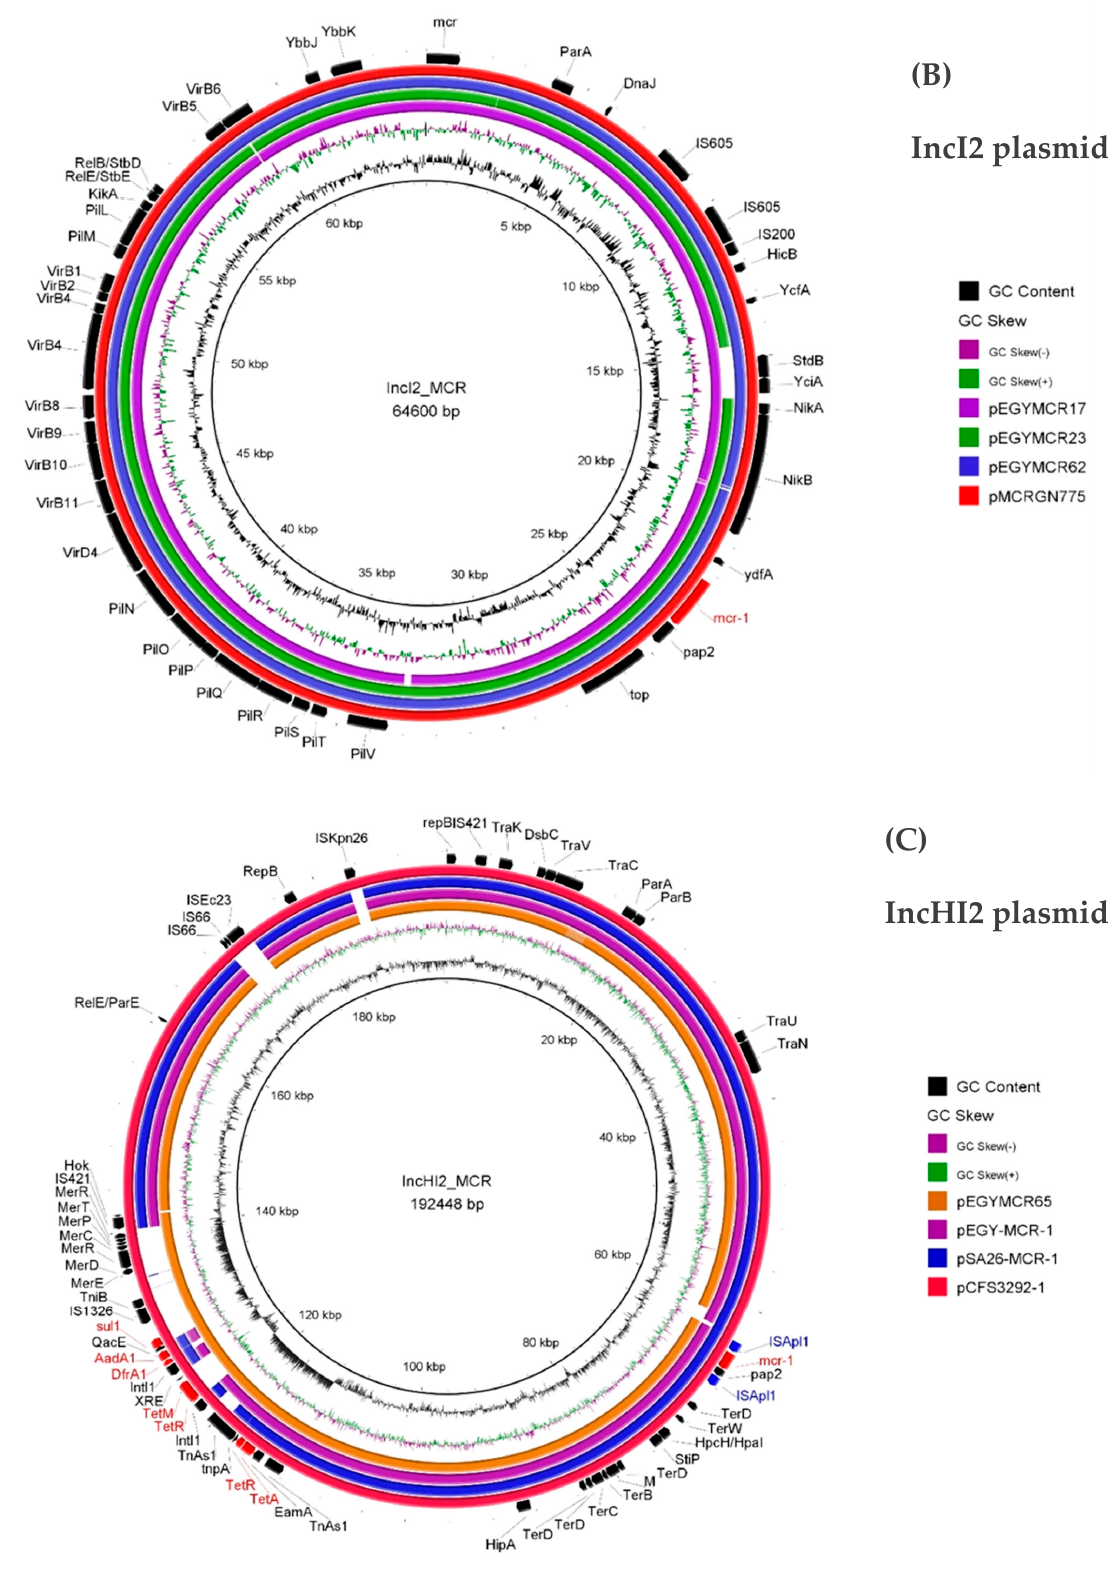
Figure 1. Circular map of mcr-1 -positive plasmids compared to other reported similar plasmids. Panel ( A ) IncX4 plasmids, panel ( B ) IncI2, panel ( C ) IncHI2. Red outer ring: plasmid used as reference for the alignment; size of the reference indicated in the middle of each panel. The different arrows indicate the positions, directions of transcription, and predicted function of the ORFs. The mcr-1 gene and IS Apl1 are marked in red and blue, respectively. The circular maps were generated using the BRIG